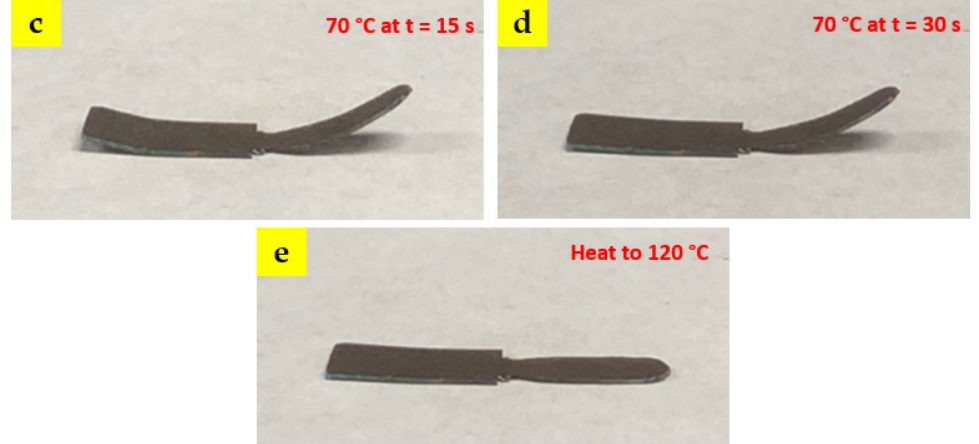
Figure 10. Demonstration of the SMA using a hot plate at 70 °C and 120 °C: ( a ) The bi-metallic SMA sample was bent at both the TiNi substrate side and the DED Ti–Ni–Cu alloy side and placed at 70 °C at t = 0 s. ( b ) t = 10 s. ( c ) t = 15 s. ( d ) t = 30 s. Notice that the TiNi substrate has almost recovered